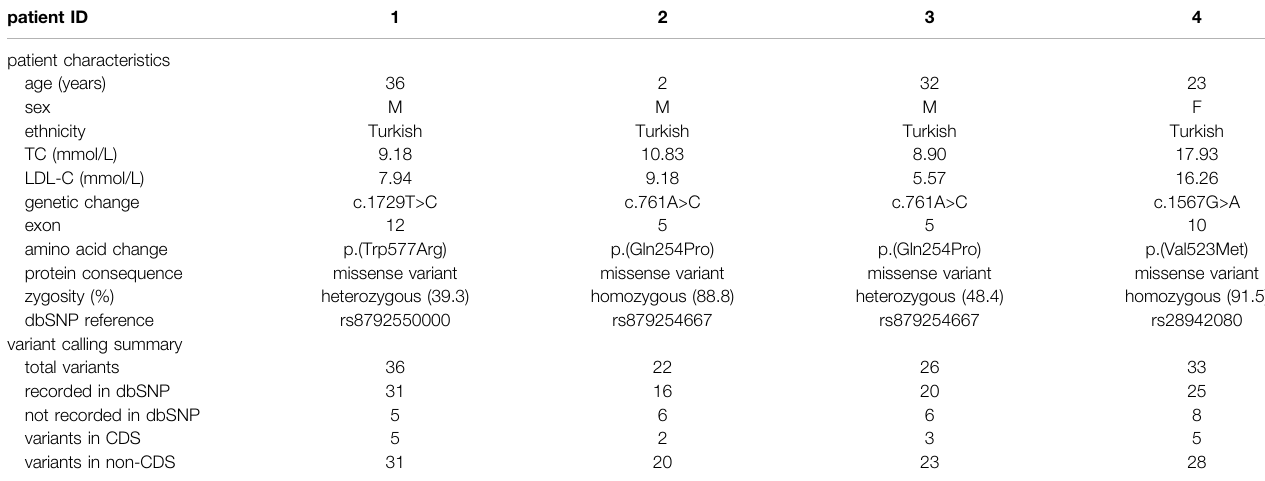
TABLE 1 | Characteristic of patients selected for the validation experiments and work fl ow results.